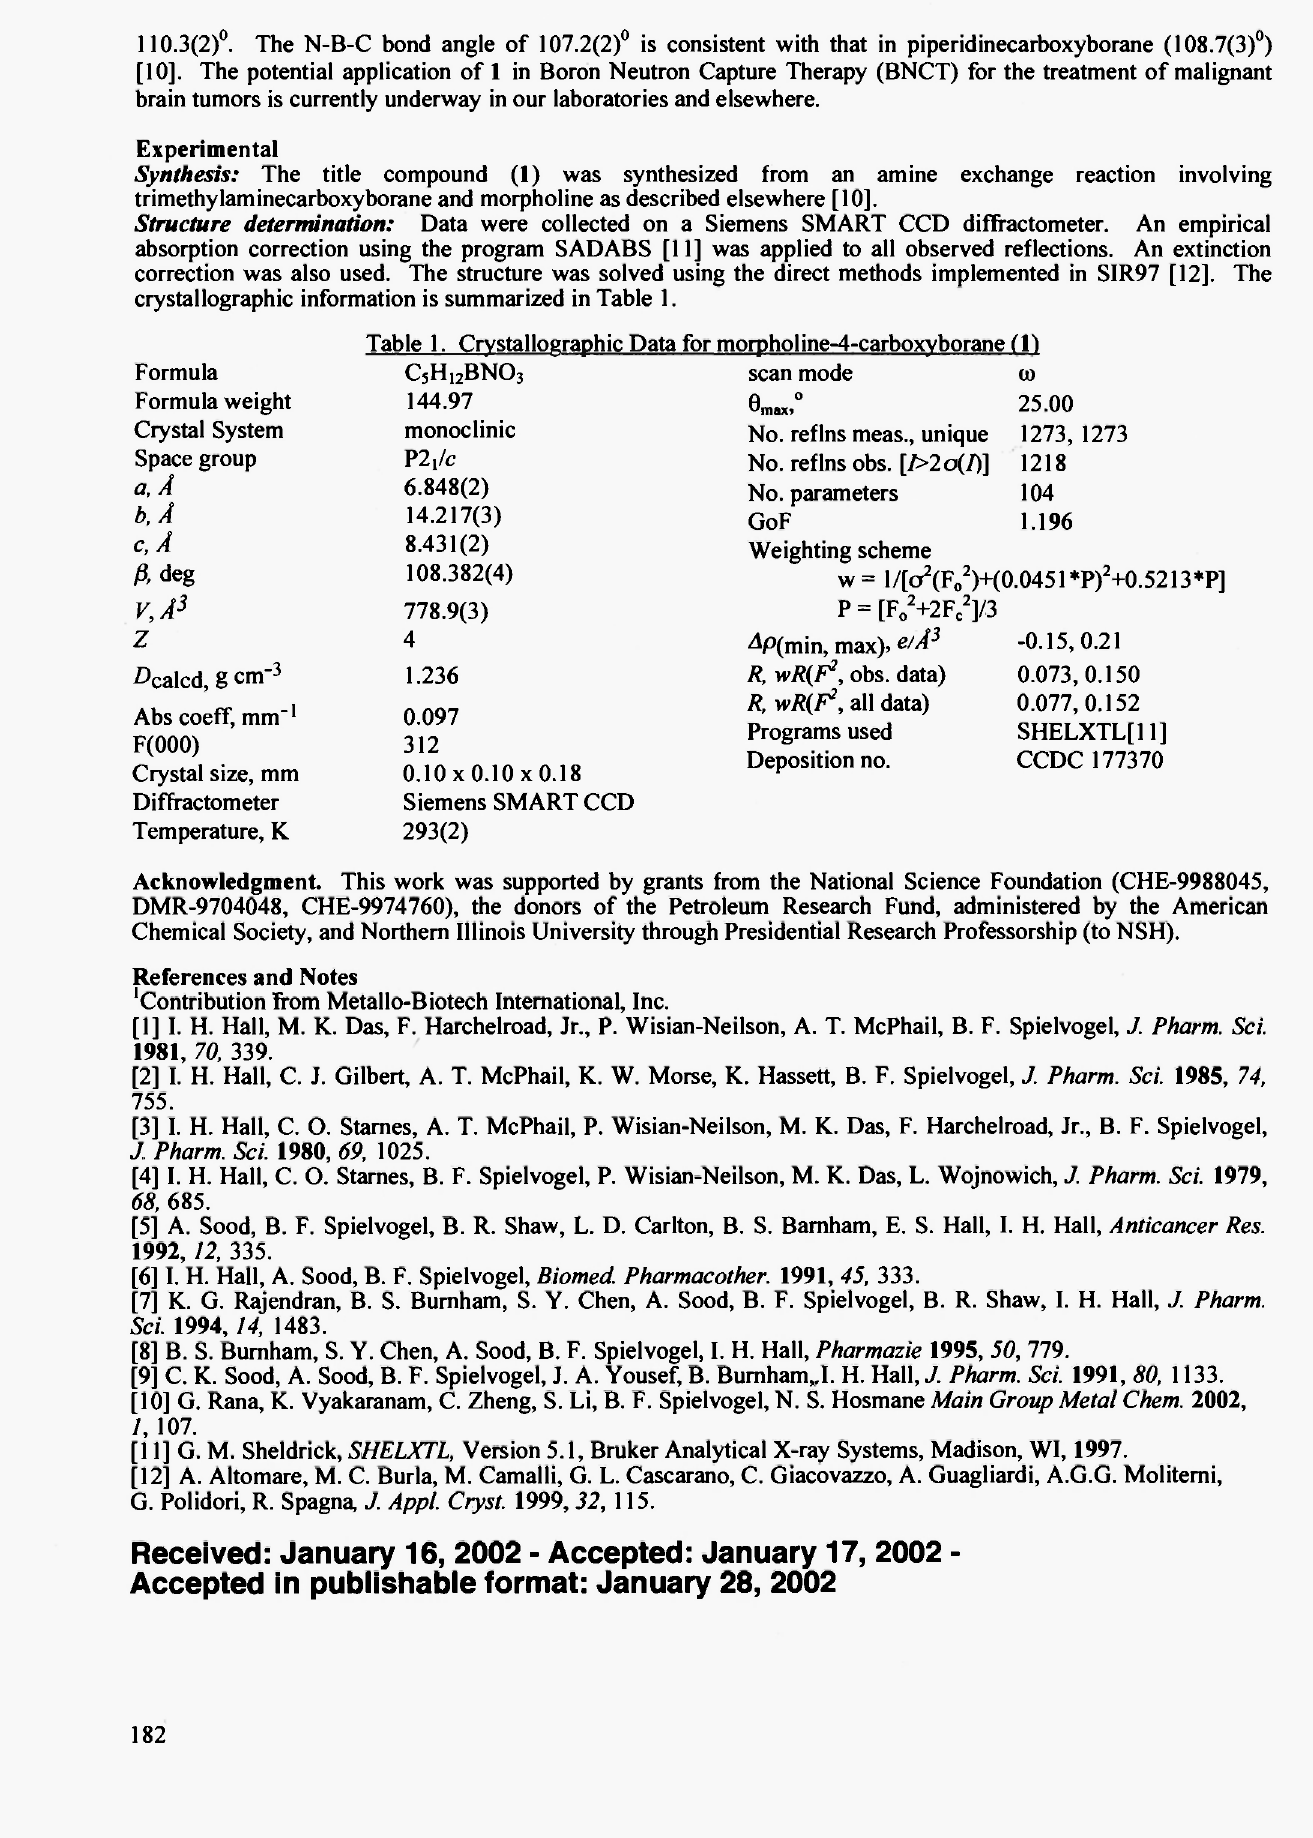
Table 1. Crystallographic Data for morpholine-4-carboxyborane